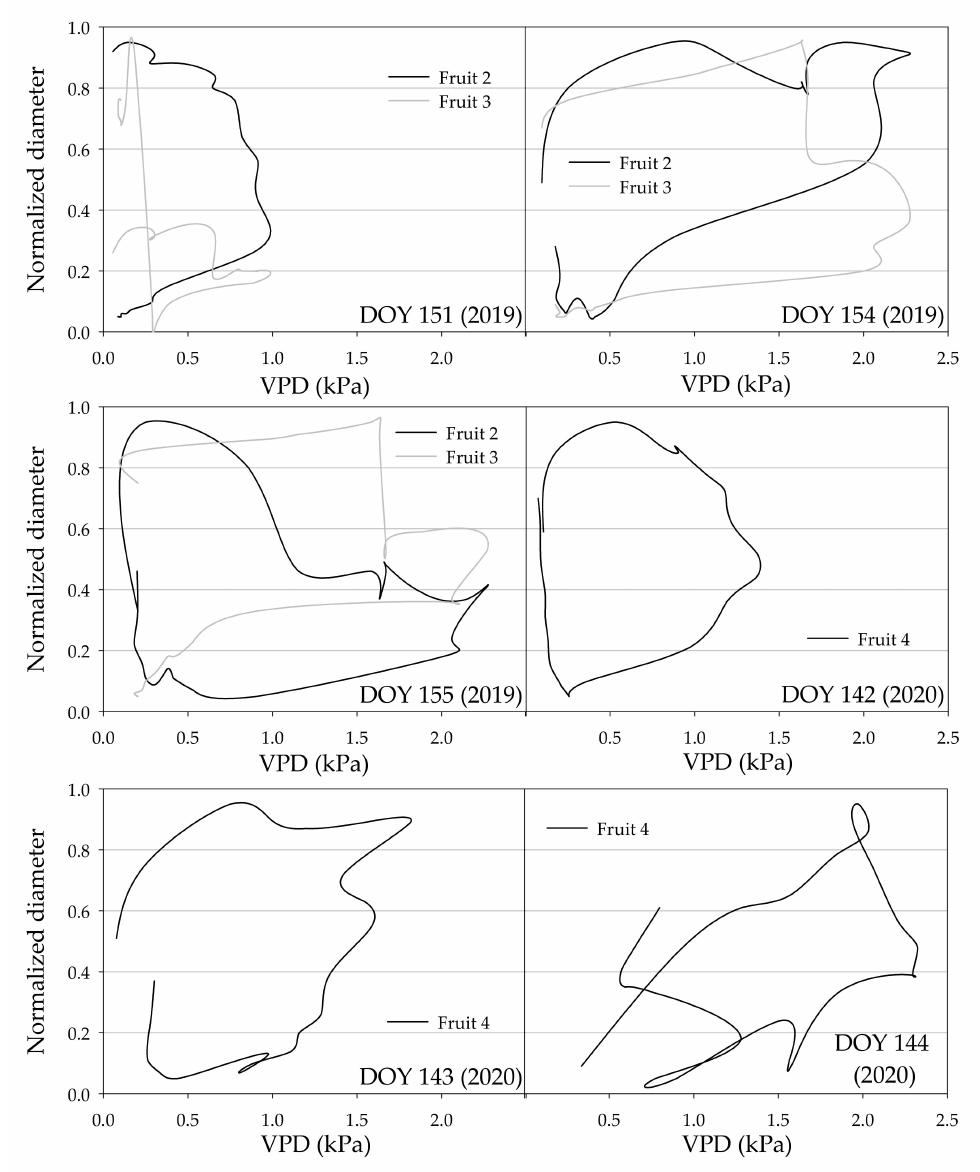
Figure 7. Most representative relations between VPD and transversal diameter in fruit growth stage 4 in 2019 and